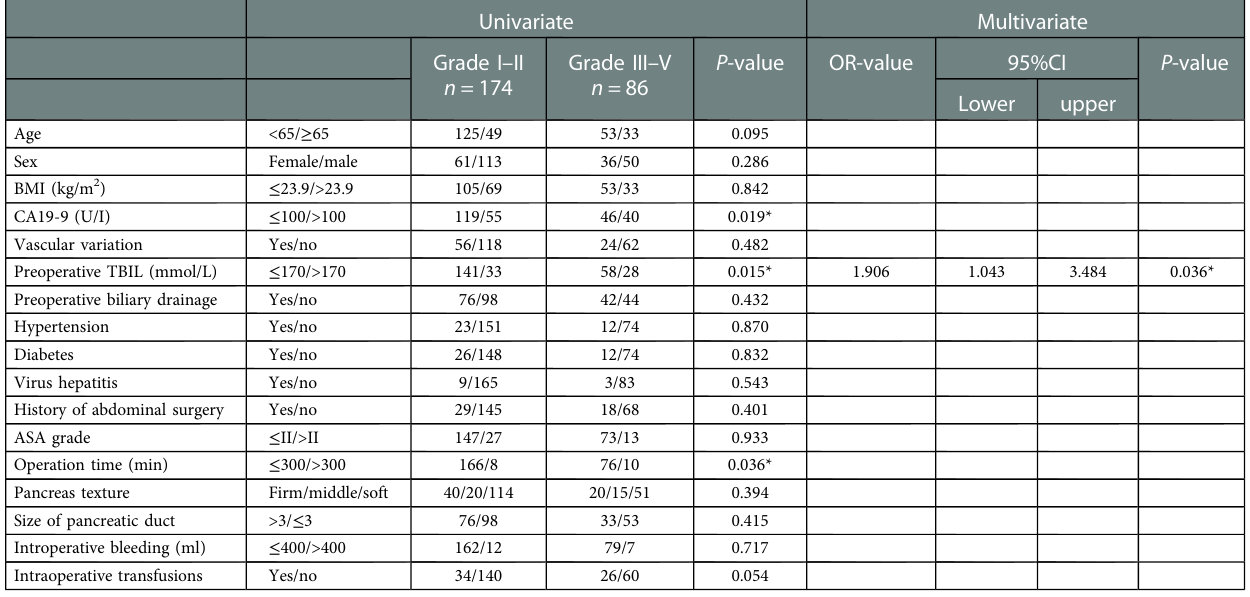
TABLE 5 Univariate and multivariate analysis of complication